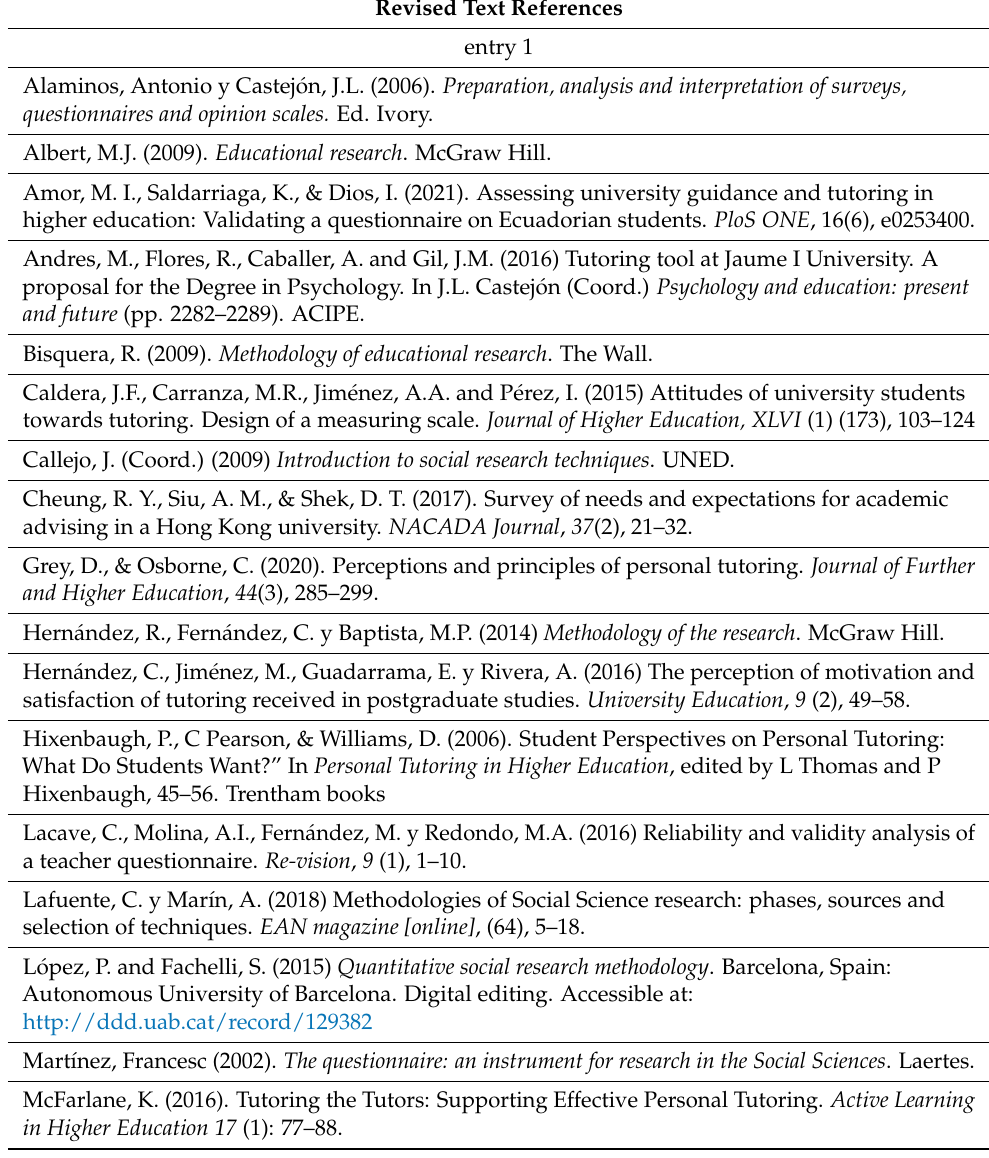
Table 1. Examples of revised